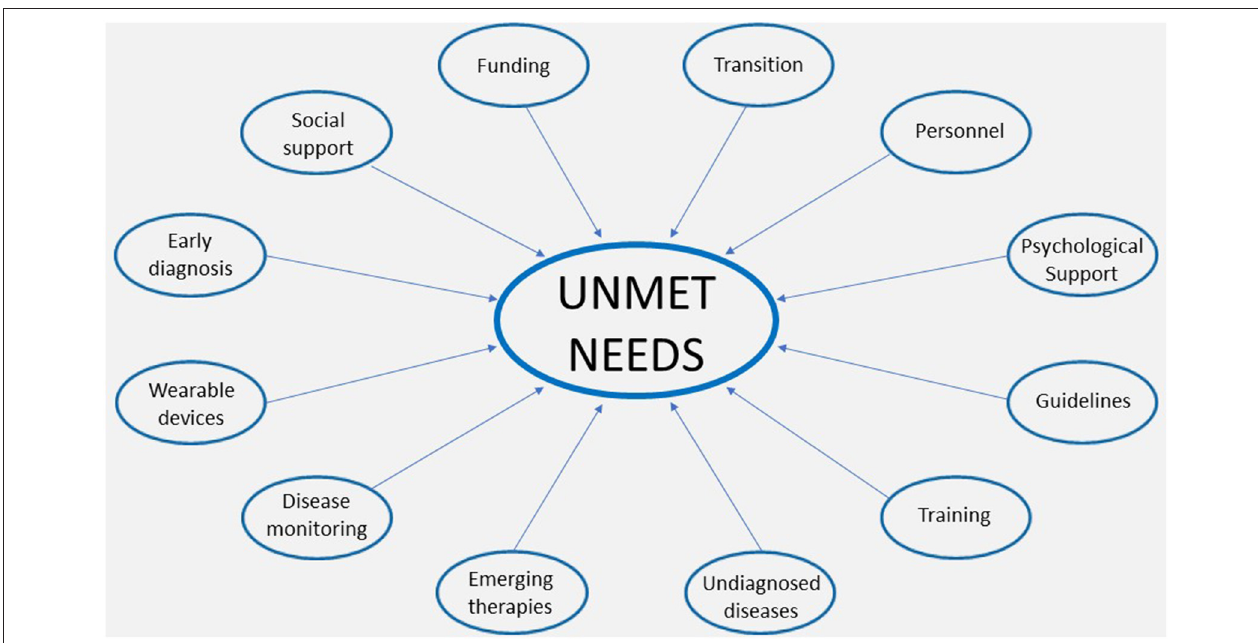
FIGURE 1 | Unmet needs in adult patients with